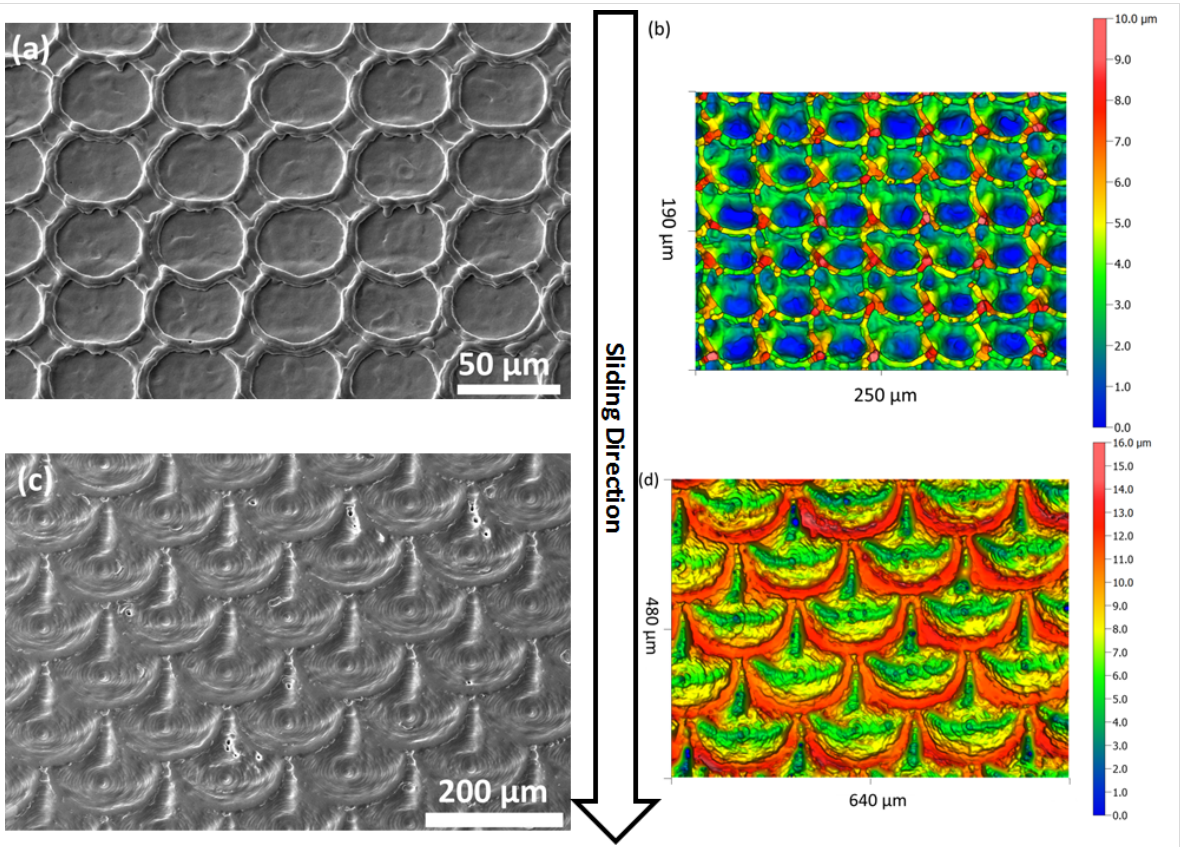
Figure 1: Scanning electron microscopy and white light profilometry images of laser-textured bearing steel (100Cr6) surfaces with biologically inspired scale-like surface morphologies. (a,b) A linear arrangement in parallel rows as tested under dry and lubricated sliding against metallic, polymeric and ceramic counter bodies. (c,d) Arrangement with an offset. The secondary electron SEM images in (a,c) were taken under a tilt angle of 30°. The sliding direction for the textured pins is indicated by the arrow.